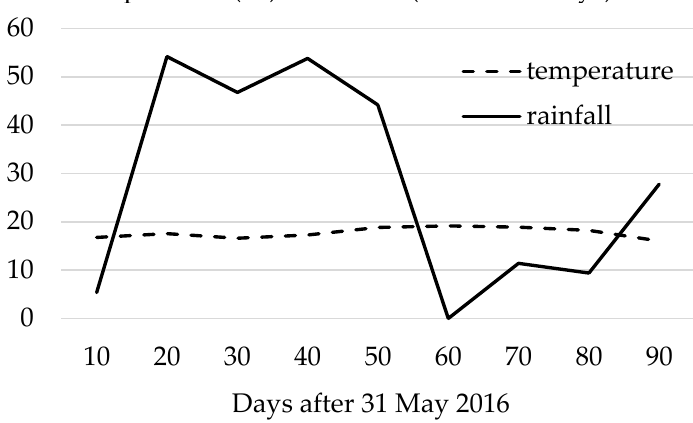
Figure 2. Mean temperature and cumulative rainfall for 10-day intervals from 1 June to 29 August 2016. Table 1. Matrix of Pearson Correlation coefficients among clay content, soil organic carbon (SOC), and elevation differential (ED). Bold values indicate significance at p < 0.001.